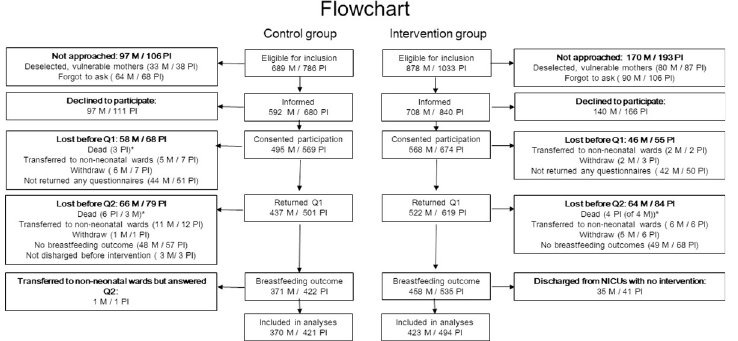
Fig 1. Flowchart. M = mothers, PI = preterm infants, Q1 = questionnaire 1, Q2 = questionnaire 2, NICU = neonatal intensive care unit. https://doi.org/10.1371/journal.pone.0245273.g001 of exclusive breastfeeding between control and intervention group (37.6 vs.37.8 weeks, p = 0.056). Rates of partial breastfeeding decreased, and rates of exclusive breastmilk fed infants increased, but the rate of no breastfeeding did not decrease significantly (Table 2). Of the six clinical practices included in the intervention, maternal self-reported use of three of them were significantly improved in the intervention group: More infants continued daily skin-to-skin contact after incubator care (83.2% vs. 88.3%, p = 0.035), less infants used a nipple shield (61.8% vs. 54.2%, p = 0.029), and more mothers initiated breast milk expression before six hours post-partum (32.6% vs. 42.4%, p = 0.007, Table 3). There were no significant